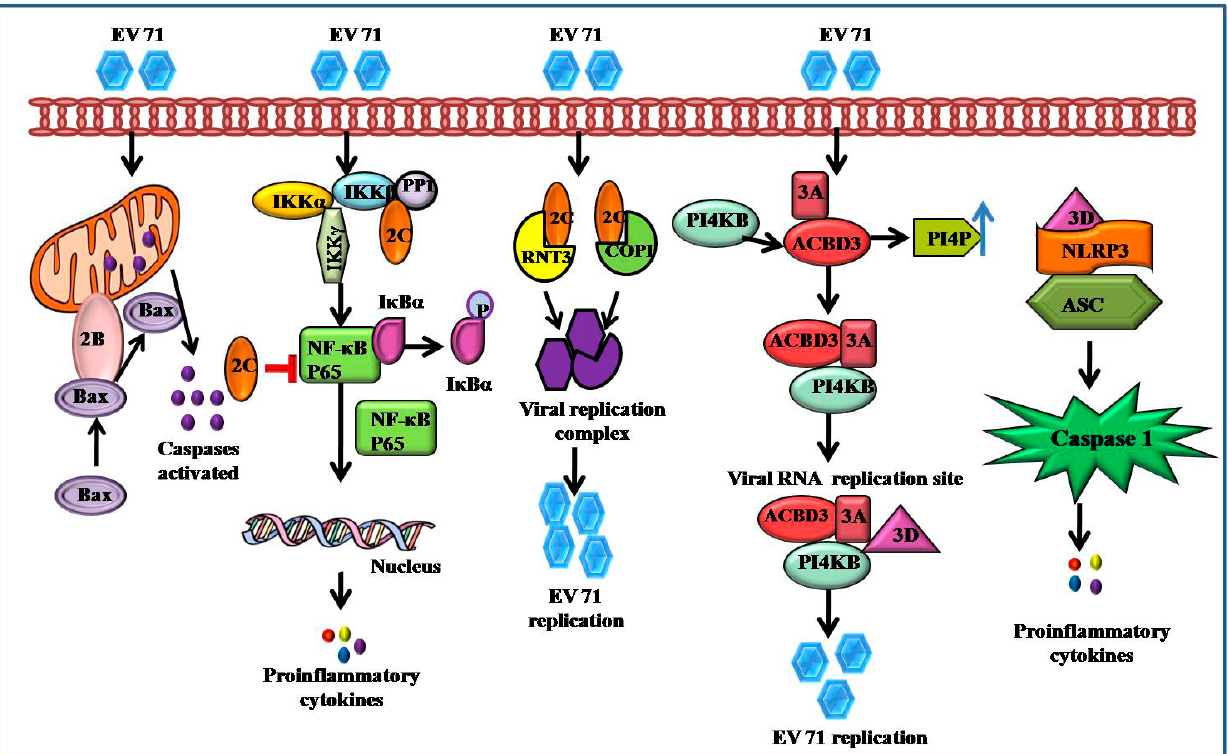
Figure 3. A graphical illustration of the role of each protein in EV71-induced signaling pathways. By directly interacting and activating the pro-apoptotic protein Bax, 2B triggers cell apoptosis. The overexpression of anti-apoptotic protein Bcl-XL prevents 2B-induced caspase activation and cytochrome C release. 2C protein exhibits both RNA and membrane-binding activity, interacts with reticulon 3 (RNT3), then combines with double-stranded RNA viruses to form a viral replication complex and participates in viral replication. By interacting with 3A protein, the Golgi protein acylcoenzyme A binding domain-containing 3 (ACBD3) facilitates EV71 replication, and triggers the generation of IL-1 β by activating NLRP3